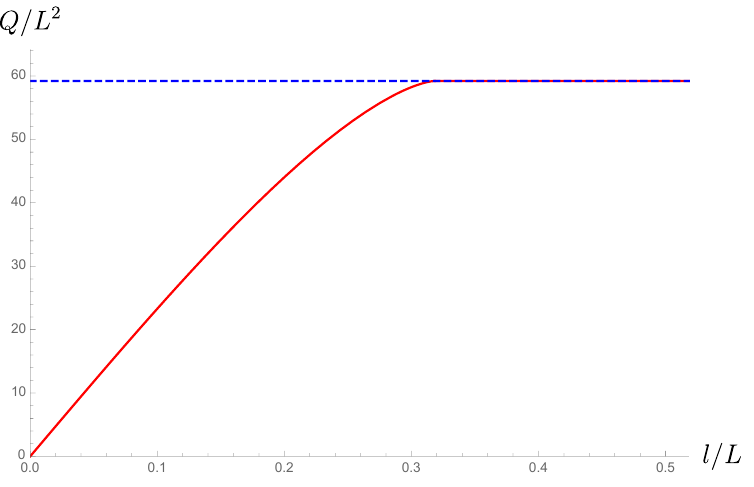
Figure 1 . Di(cid:11)erent types of hypersurface depending on whether L > (cid:25)l or L < (cid:25)l . For simplicity, we only show the compact dimension, y 5 , and one extended dimension, y 2 .